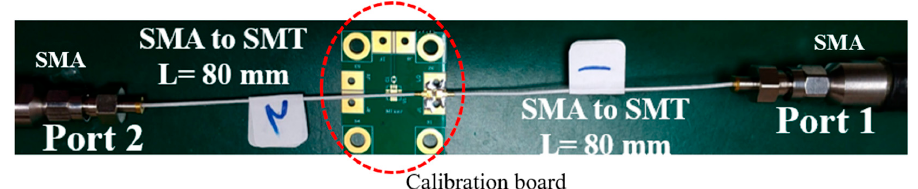
Figure 6. Calibration setup for the loss between SMA and SMT connectors.